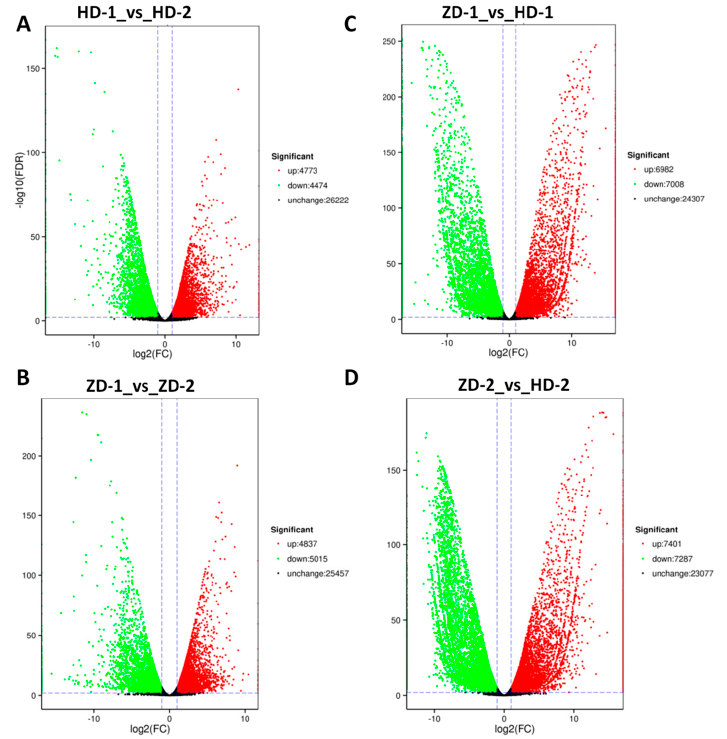
Figure 4. Volcano plot showing the up-regulated genes, down-regulated genes, and genes that were not regulated between pairs of compared samples. ( A ) HD-1_vs_HD-2, ( B ) ZD-1_vs_ZD-2; ( C ) ZD-1_vs_HD-1; and ( D ) ZD-2_vs_HD-2. HD represents the cultivar Lagerstroemia Dynamite, while ZD represents the cultivar Lagerstroemia Ebony Embers.